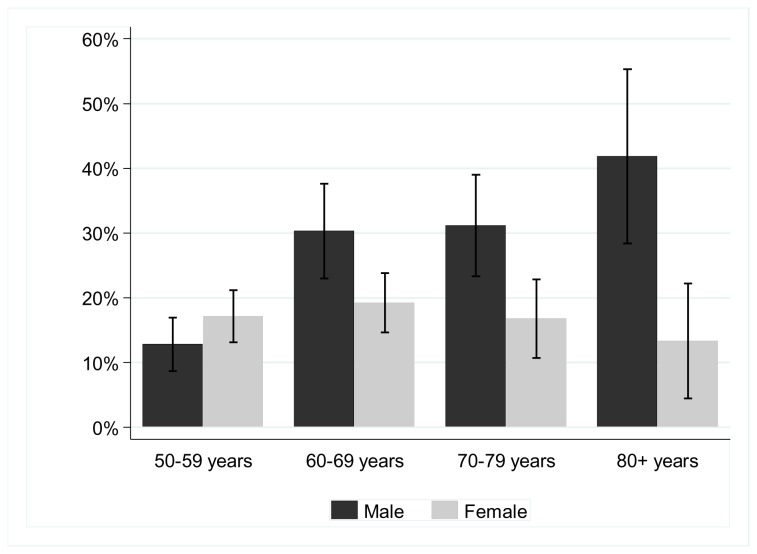
Prevalence of anaemia (and 95% confidence intervals) by age group and sex.